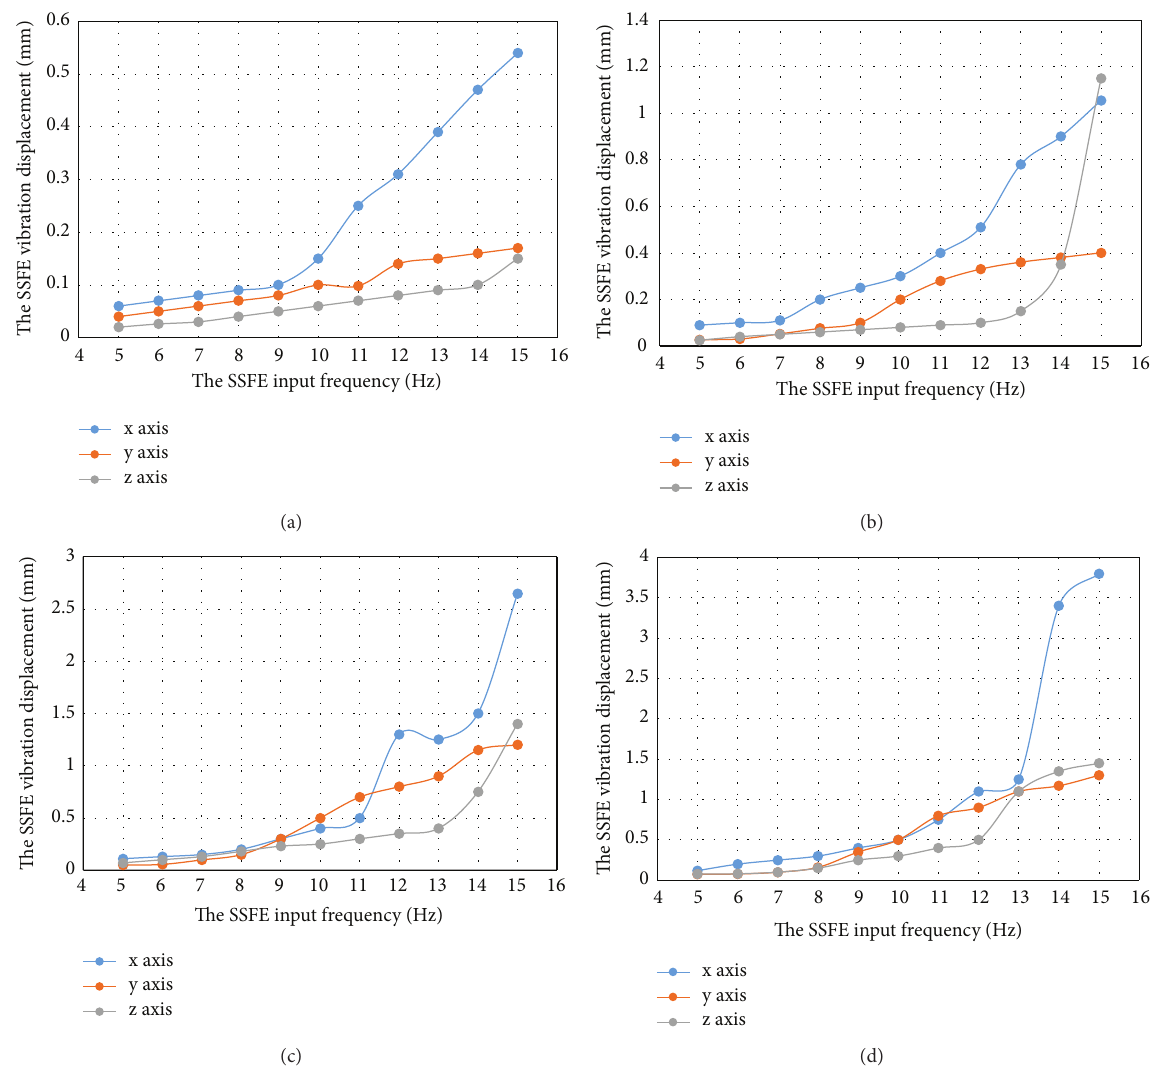
Figure 15: Under every eccentric mass, curves of the SSFE vibration displacements along the three directions changing with the SSFE input frequency. (a) Under a 1kg eccentric mass. (b) Under a 2kg eccentric mass. (c) Under a 3kg eccentric mass. (d) Under a 4 kg eccentric mass.